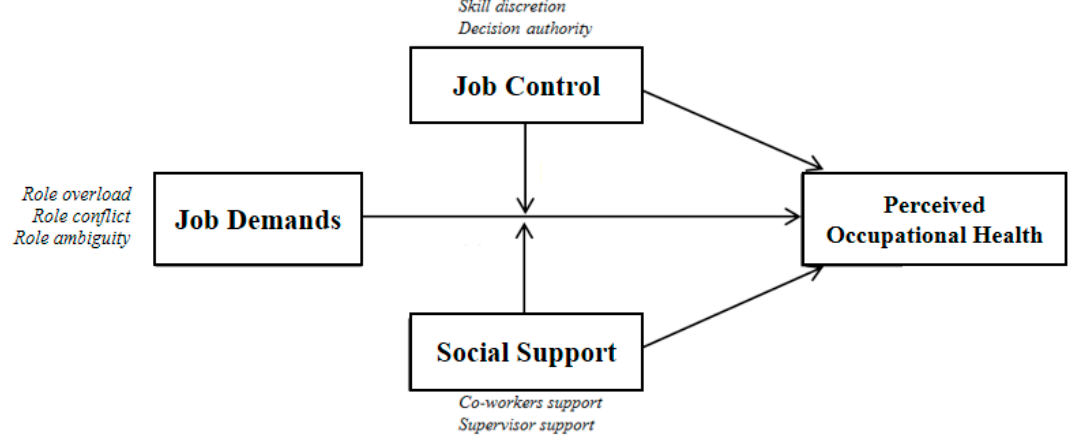
Figure 1. Model of Job Demand-Control-Support (JDCS) applied to the work of accountants.